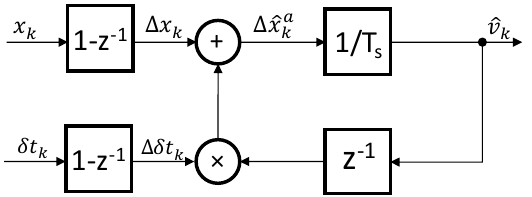
Figure 7. The block scheme of the division-less MT-type algorithm of the first order (DLMT1)